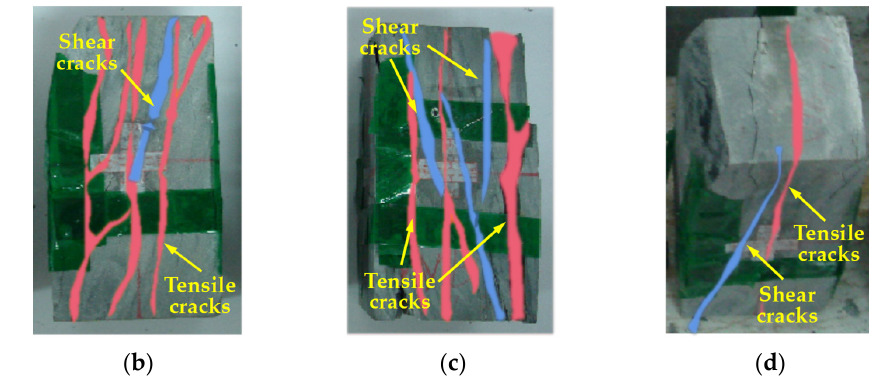
Figure 12. Fracture distribution of carbonaceous samples under parallel loading: ( a ) No. 1 sample; ( b ) No. 2 sample; ( c ) No. 3 sample; ( d ) No. 4 sample.